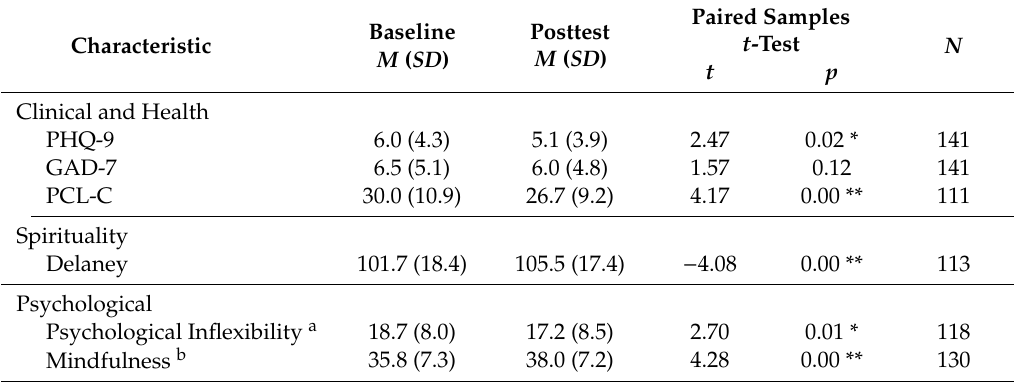
Table 4. Clinical, Spiritual and Psychological outcomes for Fall 2016–Fall 2019 SMB Wellness